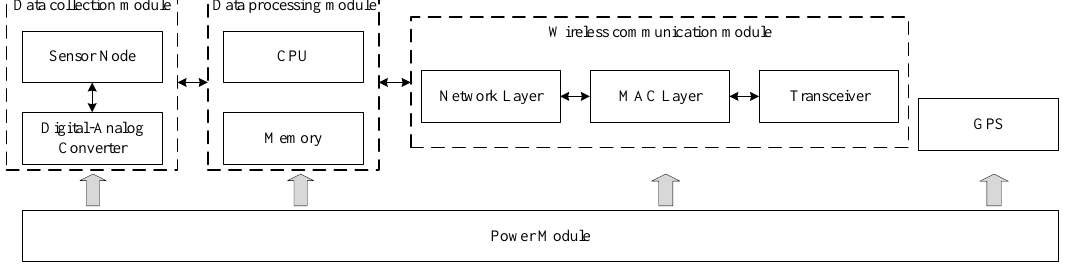
Figure 2. The main architecture of sensor nodes comprising four modules: data collection module, data processing module, wireless communication module, and power